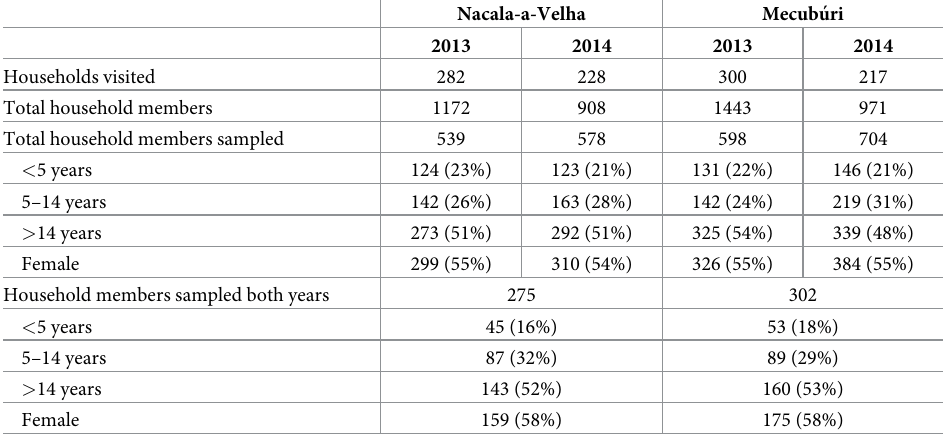
Table 1. Demographic data on study population of household surveys in Nacala-a-Velha and Mecubu´ri Districts, Mozambique, 2013–2014.